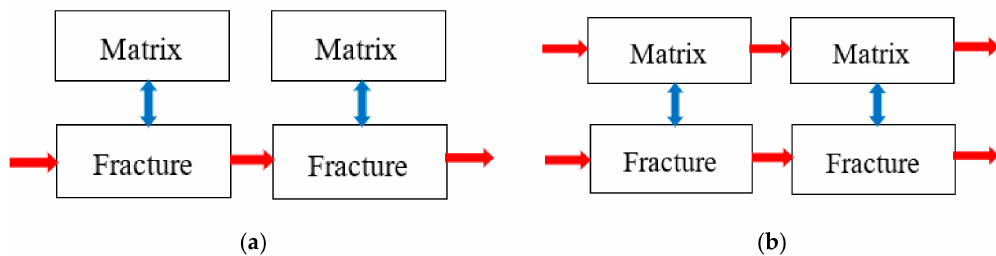
Figure 2. Schematic diagram of flow characteristics for dual-continuum medium models. ( a ) dual-porosity model. ( b ) dual-permeability model. (The blue arrows indicate the interporosity flow. The red arrows indicate the flow pathway of the